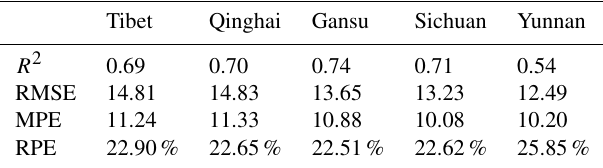
Table 3. The predictive performances of RF–GAM in different provinces over the Tibetan